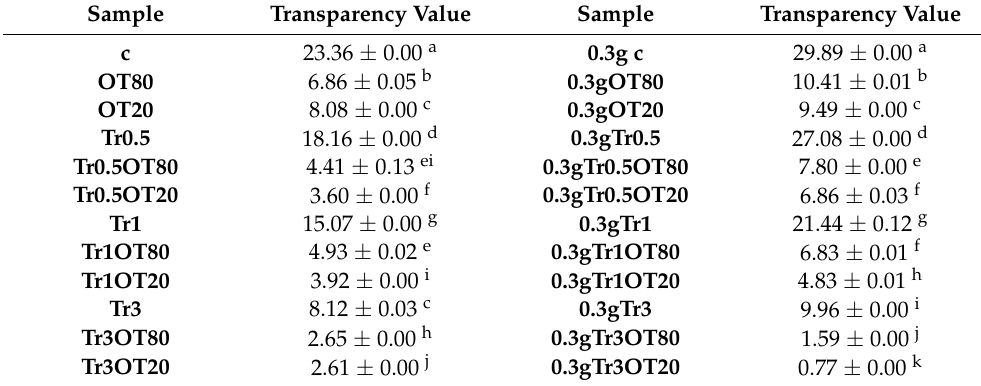
Table 3. Transparency value of